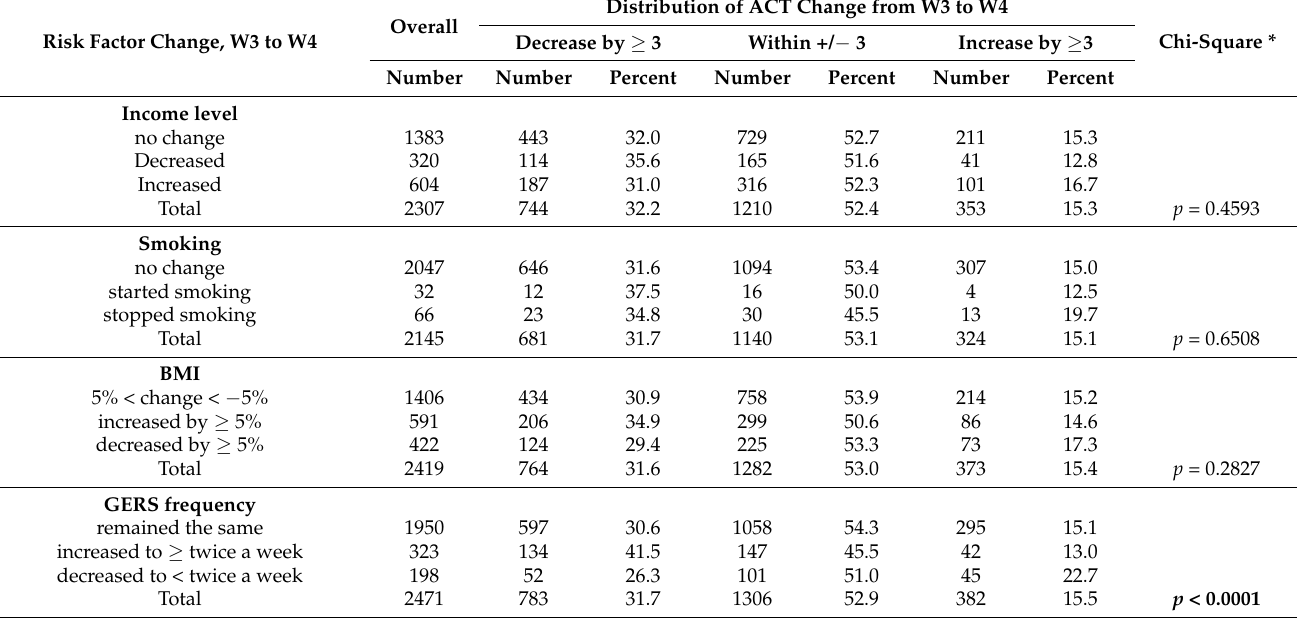
Table 3. Factors measured as the difference between W3 and W4 association between change in risk factor and change in ACT